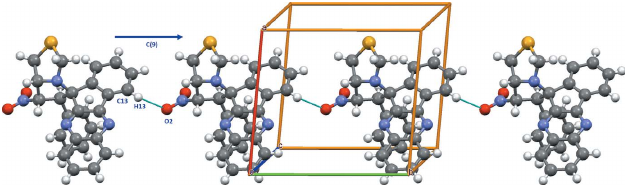
Figure 4 Chain C (9) motif, formed through a C—H (cid:3)(cid:3)(cid:3) O interaction, extending along the b -axis direction. Hydrogen bonds are shown as dashed lines.